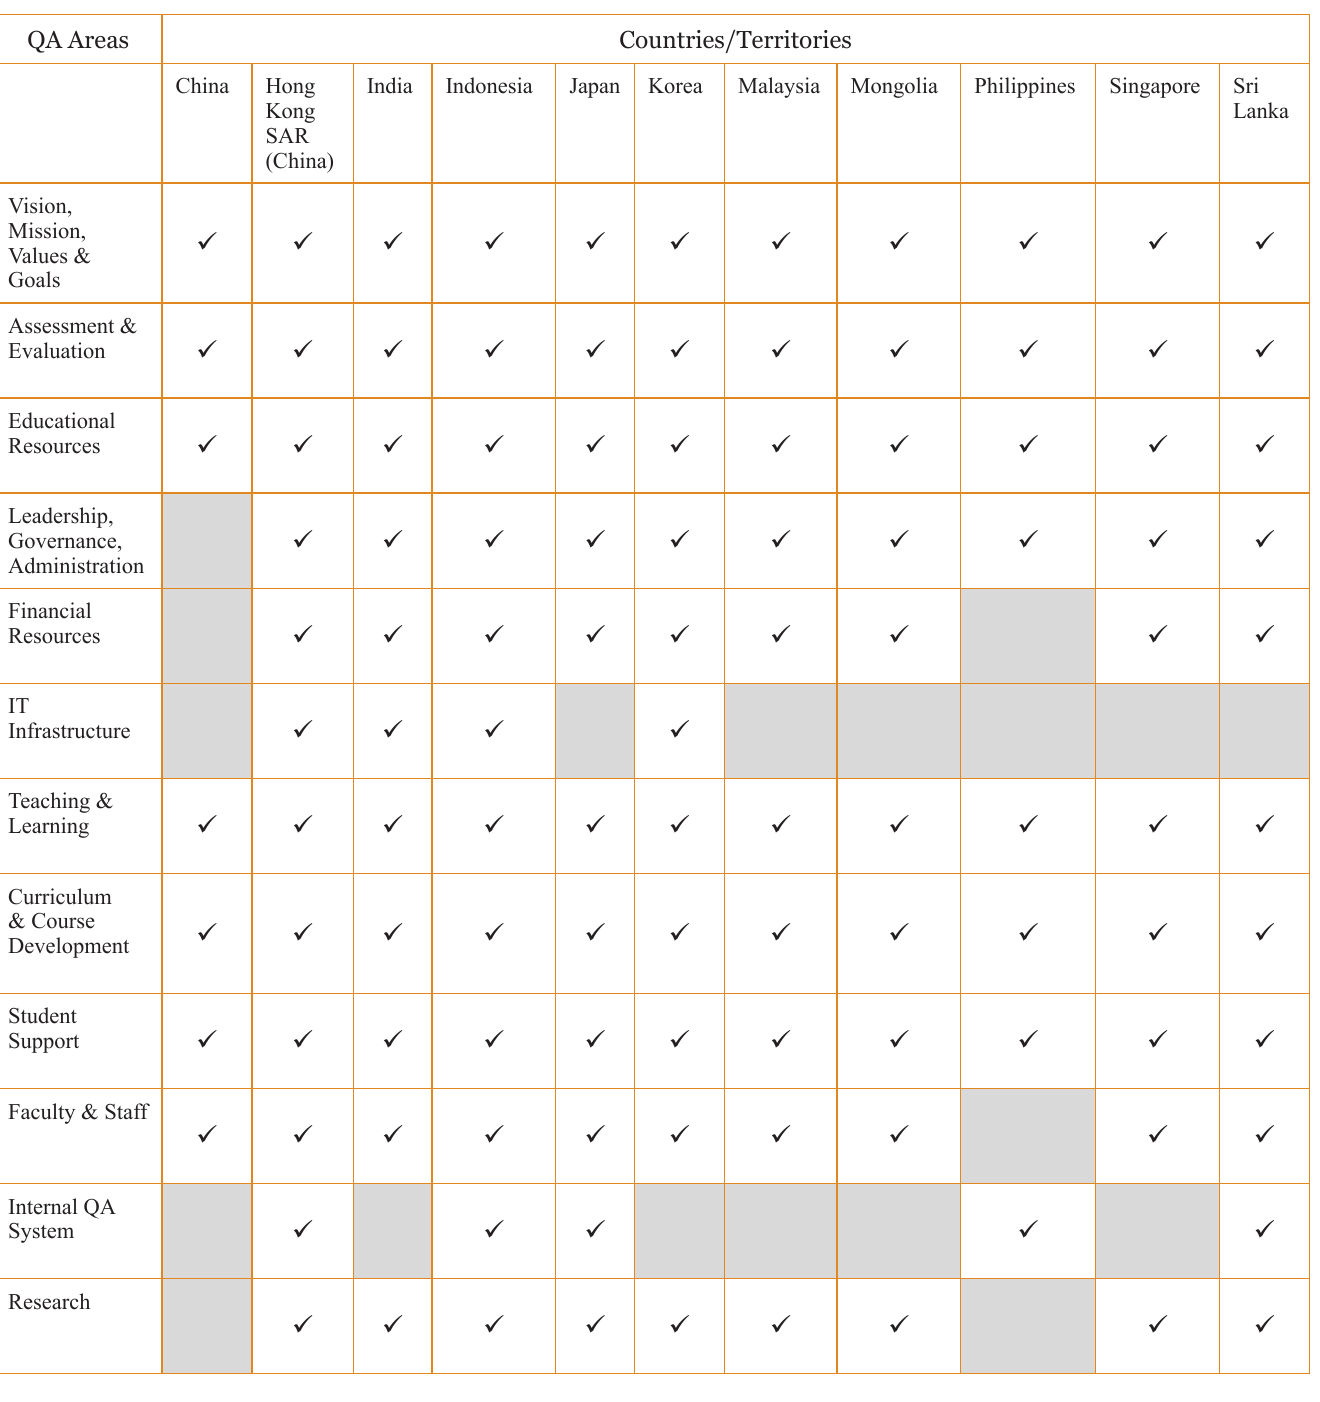
Table 2 Key QA Areas for DE in 11 Asian Countries/Territories QA